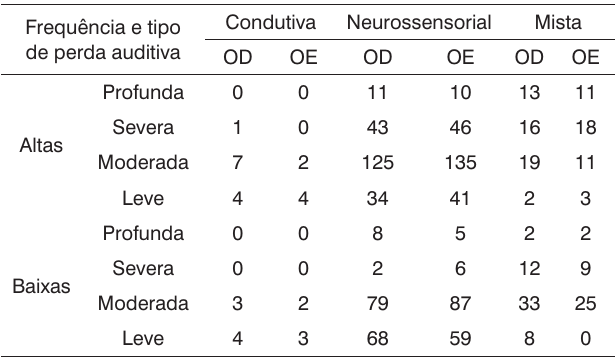
Tabela 3. Perda auditiva por orelha e padrão de normalidade nas frequências altas e